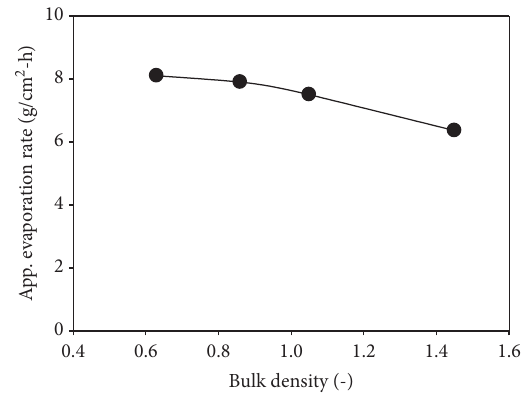
Figure 6: Relationship between the uranium deposit bulk density and apparent evaporation rates of LiCl-KCl eutectic